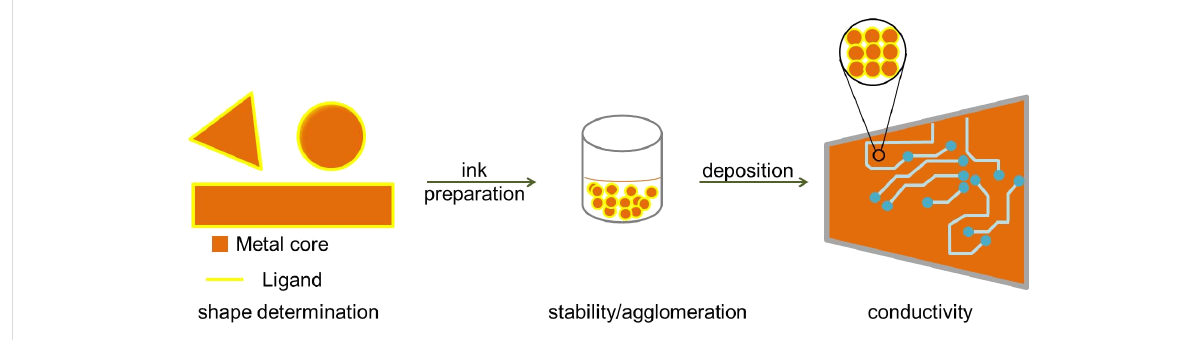
Figure 1: Ligands determine the shape of coinage-metal nanoparticles, affect the stability of their colloids and inks containing them, and the structure and properties of films deposited from such inks.